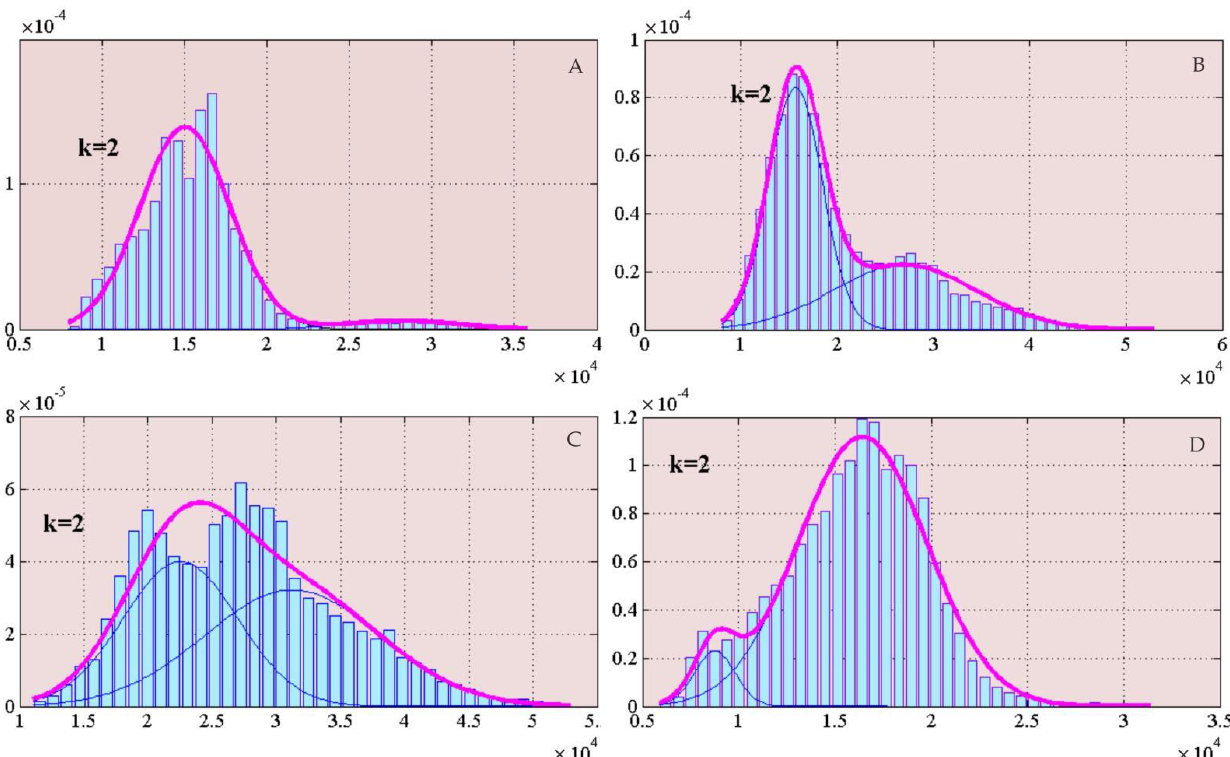
Figure 5. Sub-distribution diagram of the mixed monolithic sieving model, where ( A – D ) correspond to the results of the four gray-scale images in Figure 4, respectively.